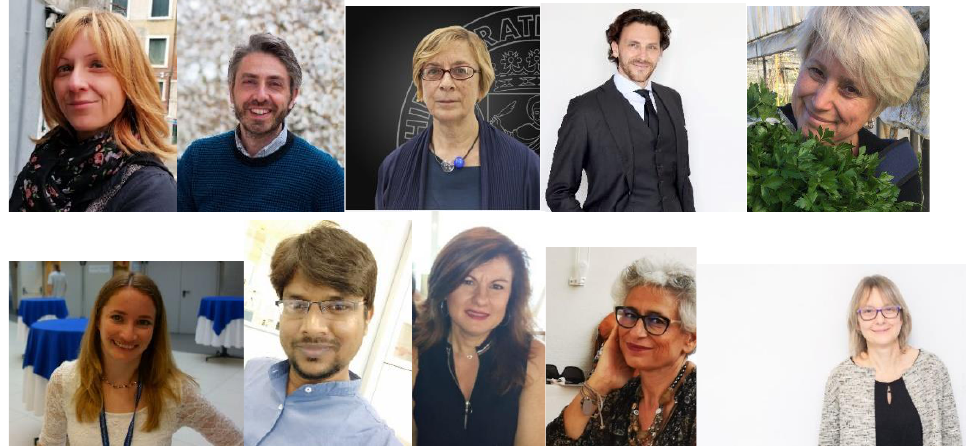
Figure 2. Monica De Palma, Alfredo Ambrosone, Antonietta Leone, Pasquale Del Gaudio, Michelina Ruocco, Lilla Turiák, Ramesh Bokka, Immacolata Fiume, Marina Tucci and Gabriella Pocsfalvi (From left to right, top to bottom).